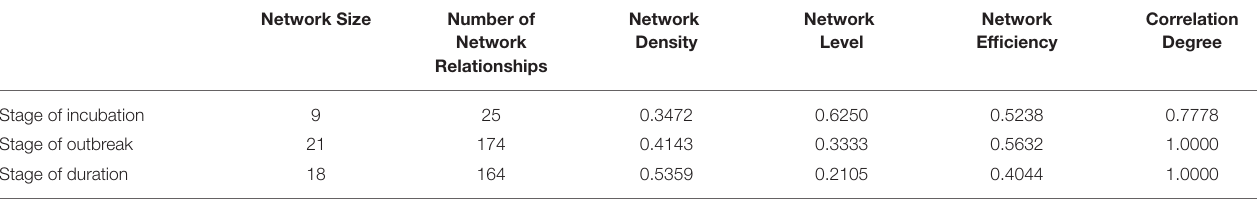
TABLE 2 | Integrated network analysis of the central-local